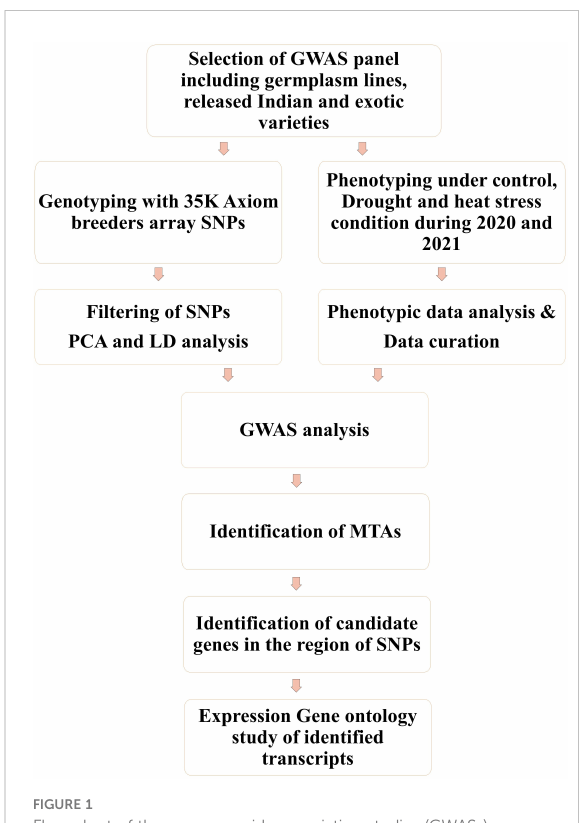
FIGURE 1 Flow chart of the genome-wide association studies (GWASs)